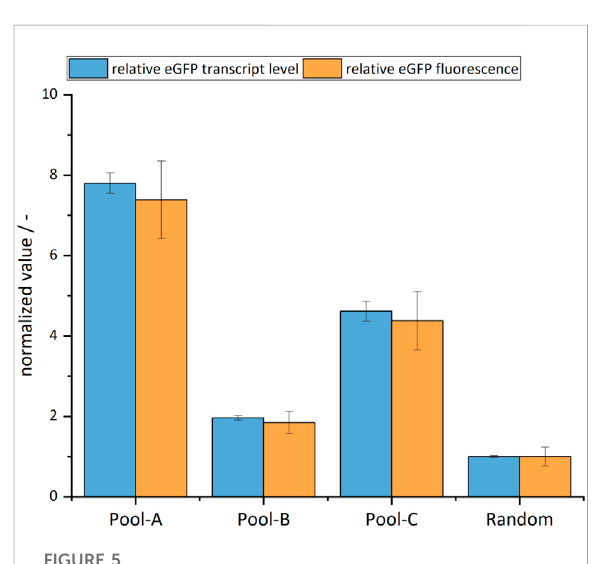
FIGURE 5 Relative transcript levels and fl uorescence of eGFP of site- speci fi c cell pools and the random cell pool set to 1. The error bars represent the standard deviation of the technical